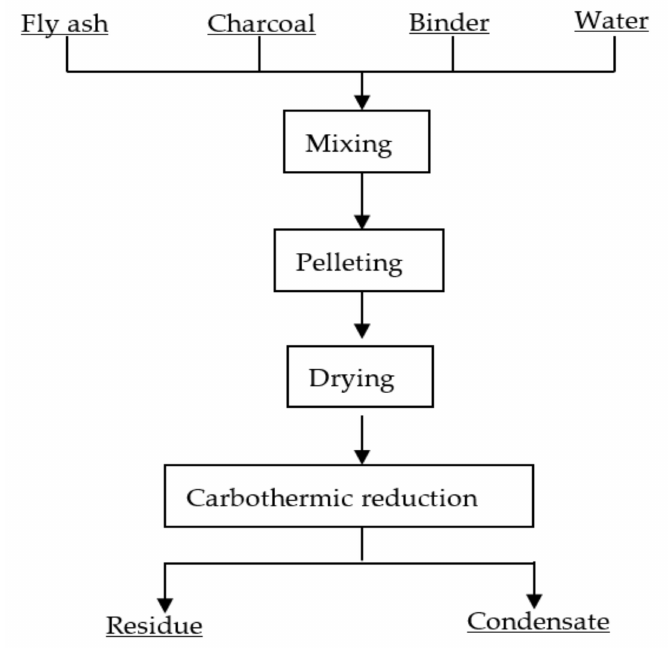
Figure 3. A flowsheet of carbothermic reduction of fly ash in the